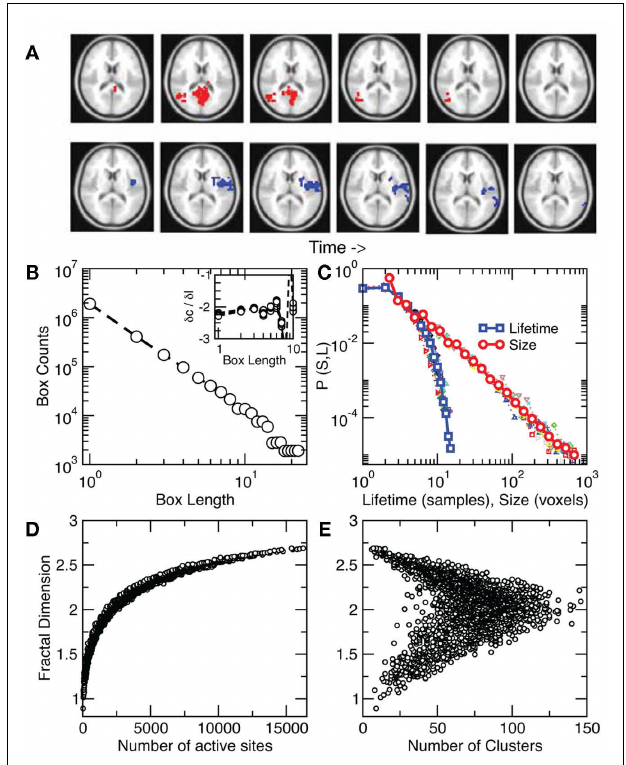
FIGURE 4 | Clusters spread throughout the brain as scale-free avalanches. (A) Two examples of avalanches, one triggered from the visual cortex (top) and another from insular cortex (bottom). Note that only a partial 2D slice is depicted here since avalanches evolve in 3D. (B) Average cluster fractal dimension D ∼ 2.15 ± 0.02 estimated by the slope of the counts vs. length plot. Inset: derivatives between points in the main plot for each subject. (C) Avalanche size and lifetime distribution function computed from about 8000 avalanches in each of 10 subjects (individual subjects with smaller symbols).While avalanche size follows a power law, their lifetimes density decreases faster as found previously for neuronal avalanches (Beggs and Plenz, 2003).The average cluster fractal dimension is plotted as a function of the number of active sites in (D) and of the number of clusters in (E)